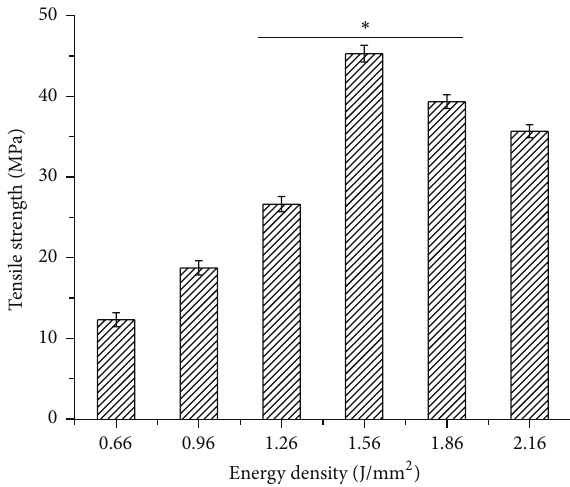
Figure 4: The relationship of tensile strength and energy density ( ∗ 𝑃 < 0.05